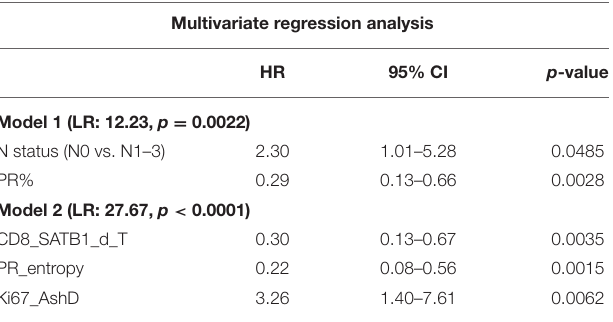
TABLE 3 | Statistics of multivariate Cox regression analyses for correlation of IHC, intratumoral heterogeneity and immune response indicators with overall survival. Multivariate regression analysis